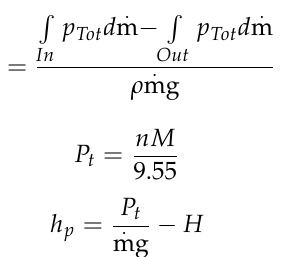
Figure 6. Evolution of each entropy production term under various operating points.